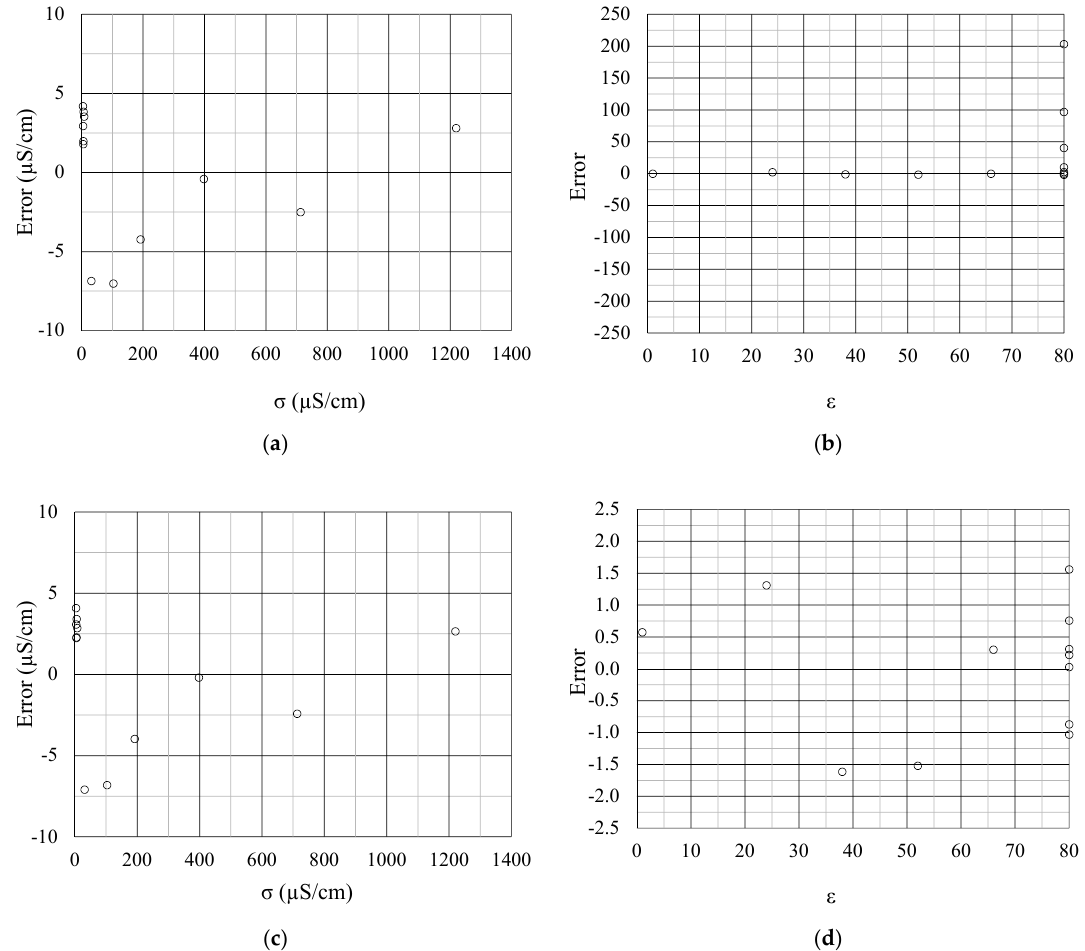
Figure 9. ( a ) Approximation method error curves to estimate σ and ( b ) to estimate ε ; ( c ) real dual-frequency method error curves to estimate σ and ( d ) to estimate ε .